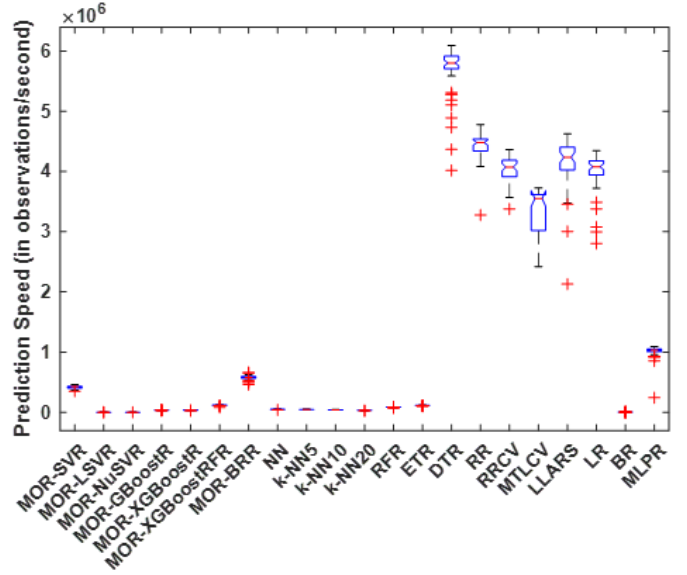
Figure 6. Box plots of PS (over 50 statistical runs) for all methods for the second